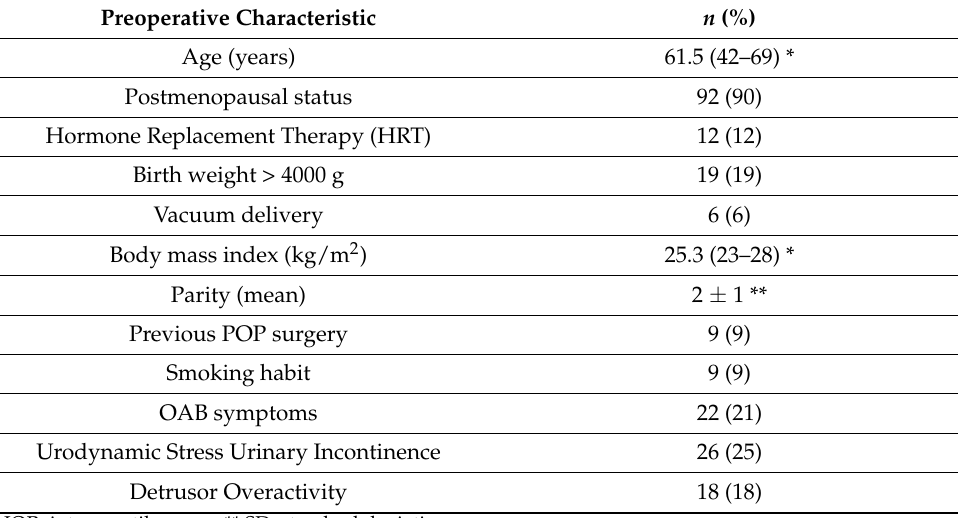
Table 1. Preoperative patients characteristics.